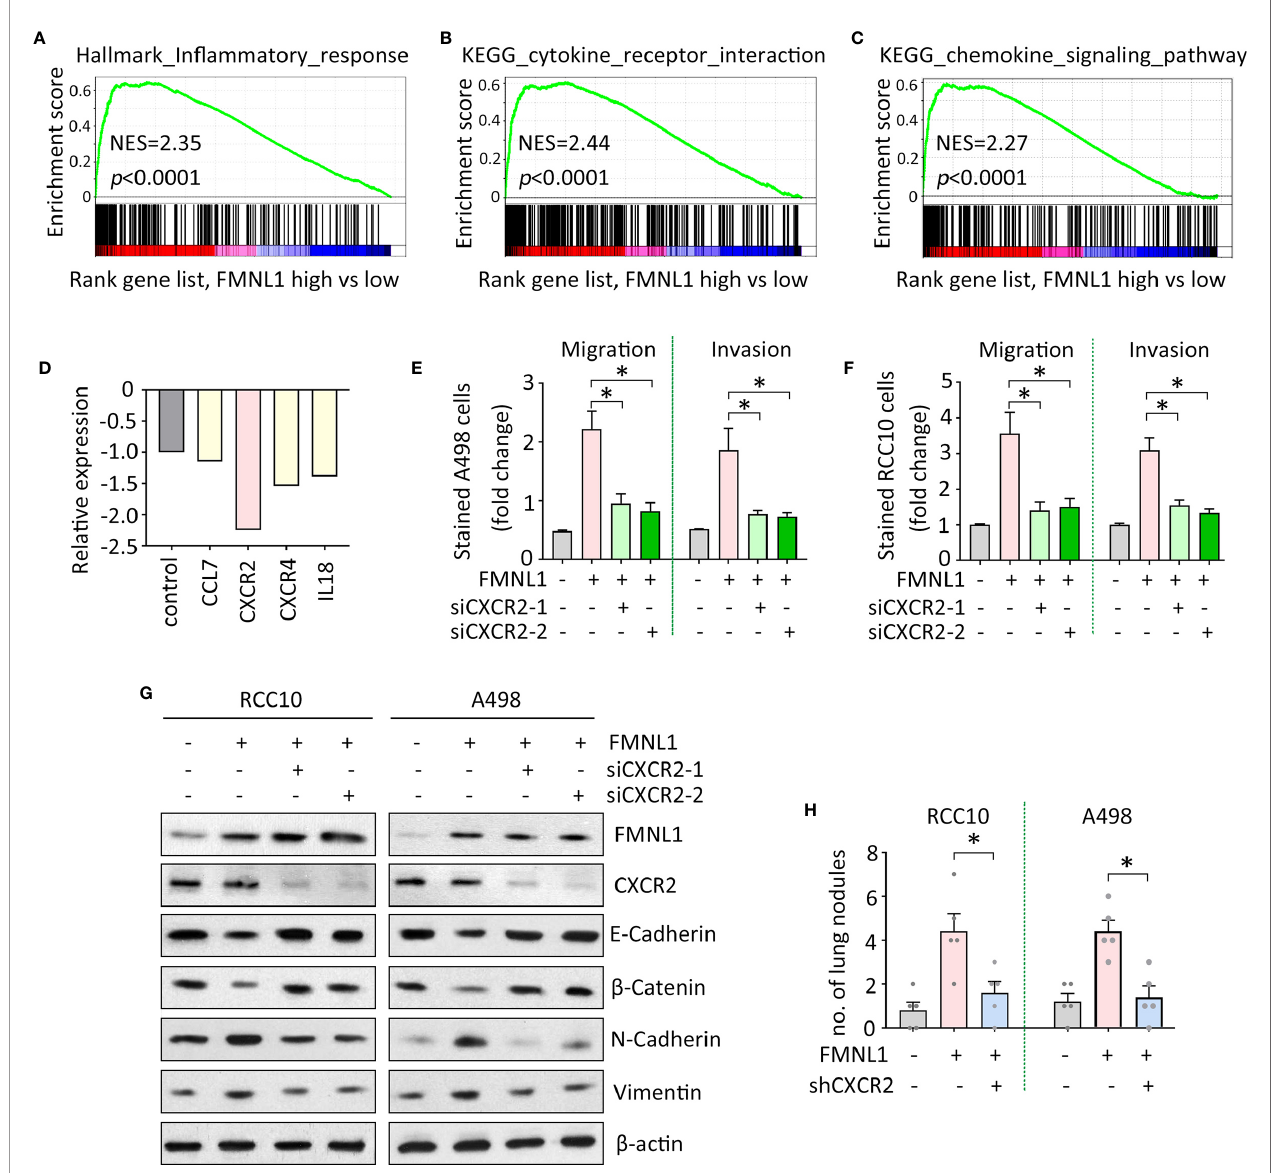
FIGURE 4 | FMNL1 exerts pro-metastatic activity via CXCR2 in ccRCC. (A – C) Gene sets enrichment analysis (GSEA) based on TCGA data showed that pathways involved in in fl ammation were activated in ccRCC patients with high expression of FMNL1. (D) PCR microarrays containing 84 genes were used to disclose the mechanism of FMNL1-induced cell migration. Genes related to in fl ammation were chosen for further validation. (E , F) Cells with FMNL1 overexpression were transfected with CXCR2 siRNAs. Cell migration and invasion were determined by transwell assays in A498 (E) and RCC10 (F) cells * P < 0.05. (G) Proteins were extracted from cells treated as described in E were subjected into western blot to determine the expression of EMT markers, such as E-Cadherin, b -catenin, N- Cadherin and Vimentin. b -actin served as loading control. (H) CXCR2 shRNA was introduced into RCC10 and A498 stable cells with FMNL1 overexpression. Stable cells were injected into nude mice for 40 days. Metastatic nodules in the lungs were counted and indicated by histogram. * P <